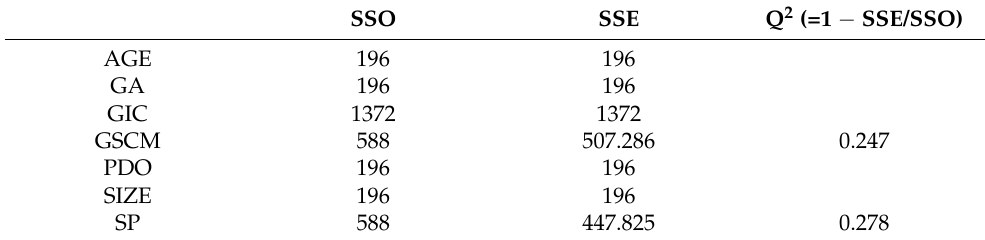
Table 6. Construct cross-validated redundancy (predictive